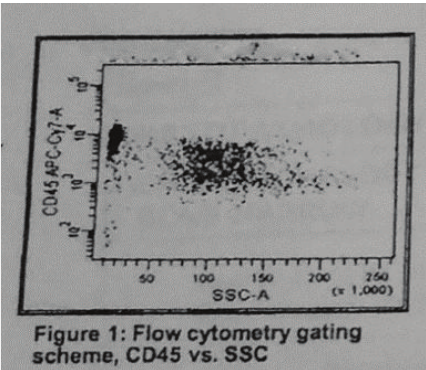
Figure 1: Flow cytometry of the bone marrow biopsy sample, negative.